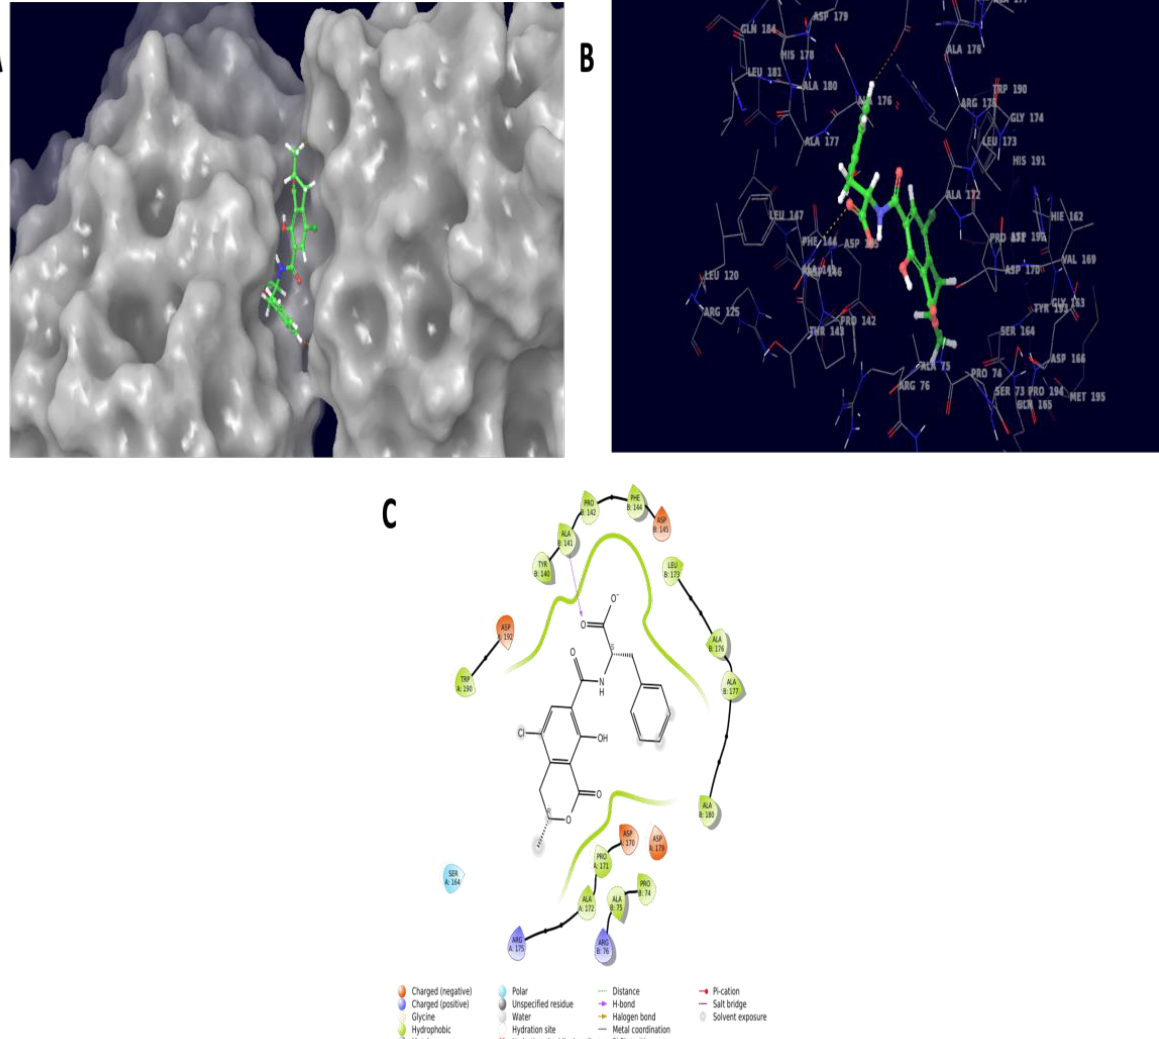
Figure 8. The docked complex molecule of carboxylesterase showing pocket binding sites ( A ), three- dimensional structure of interaction ( B ) and two-dimensional interaction diagram ( C ). This enzyme